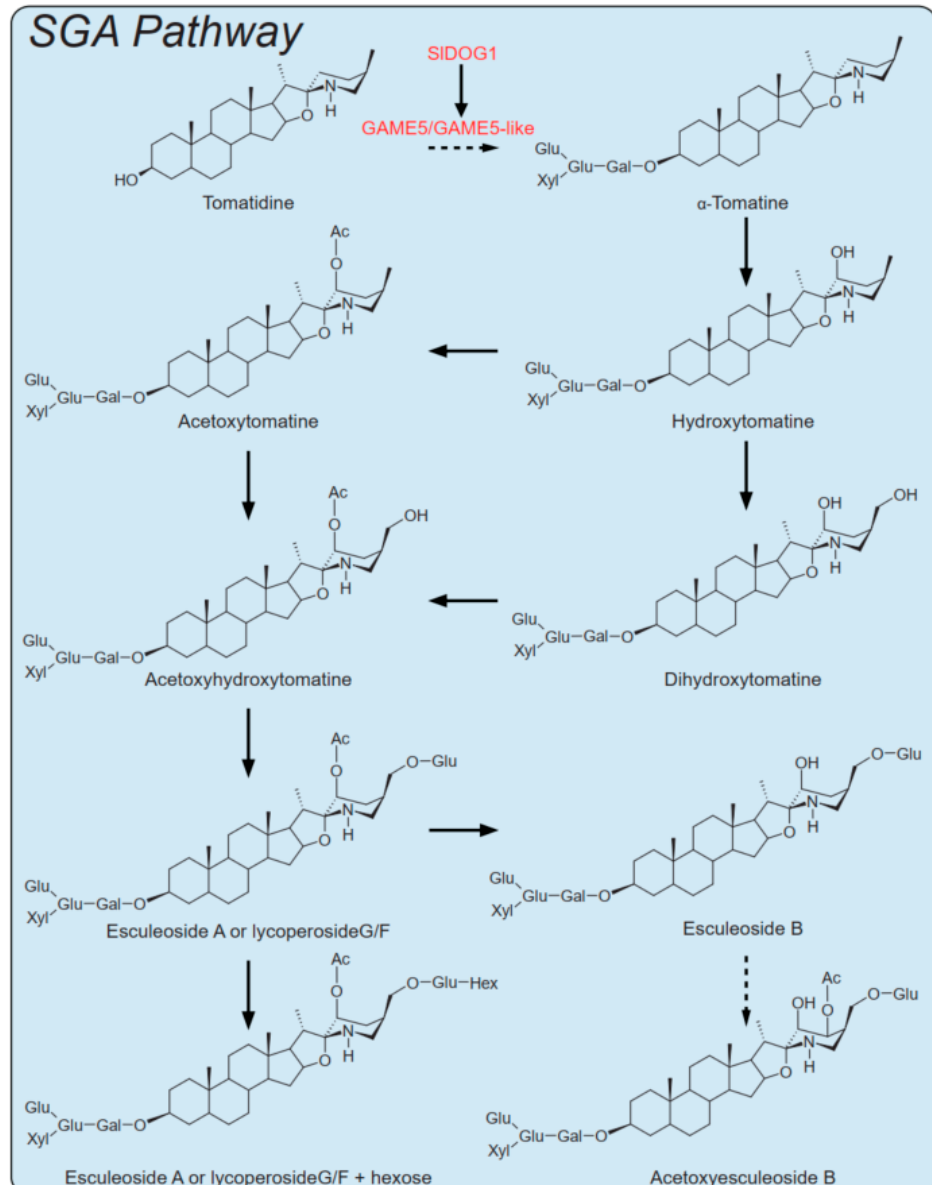
Figure 6. Core metabolic pathways: A simplified scheme of the core SGA metabolic pathway